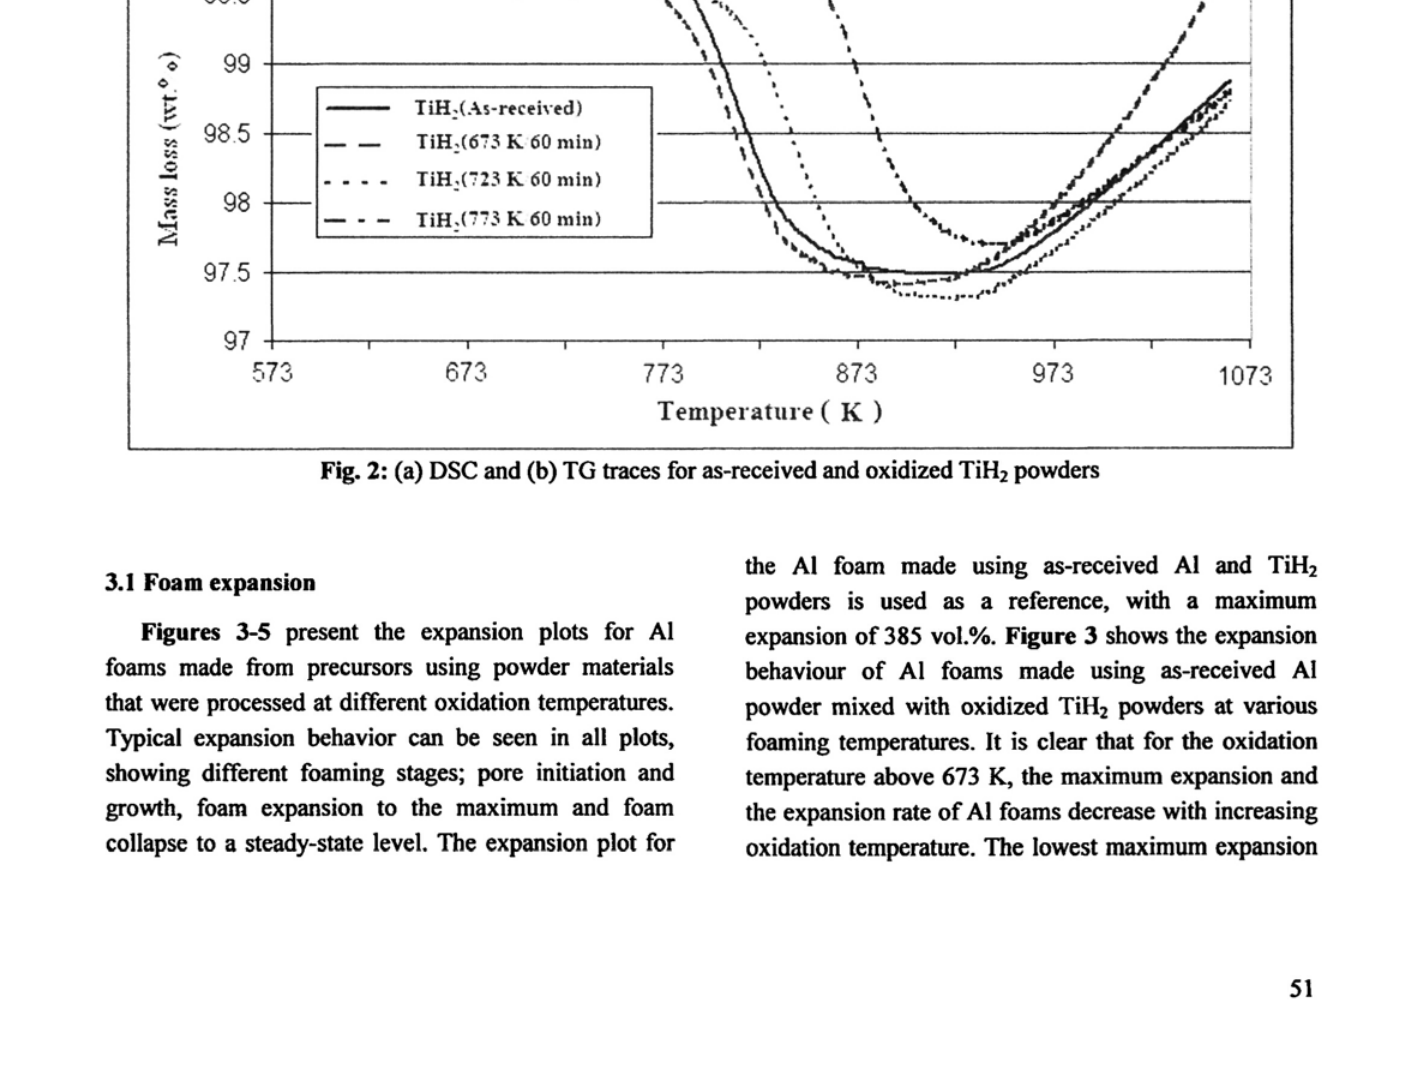
Fig. 2: (a) DSC and (b) TG traces for as-received and oxidized TiH